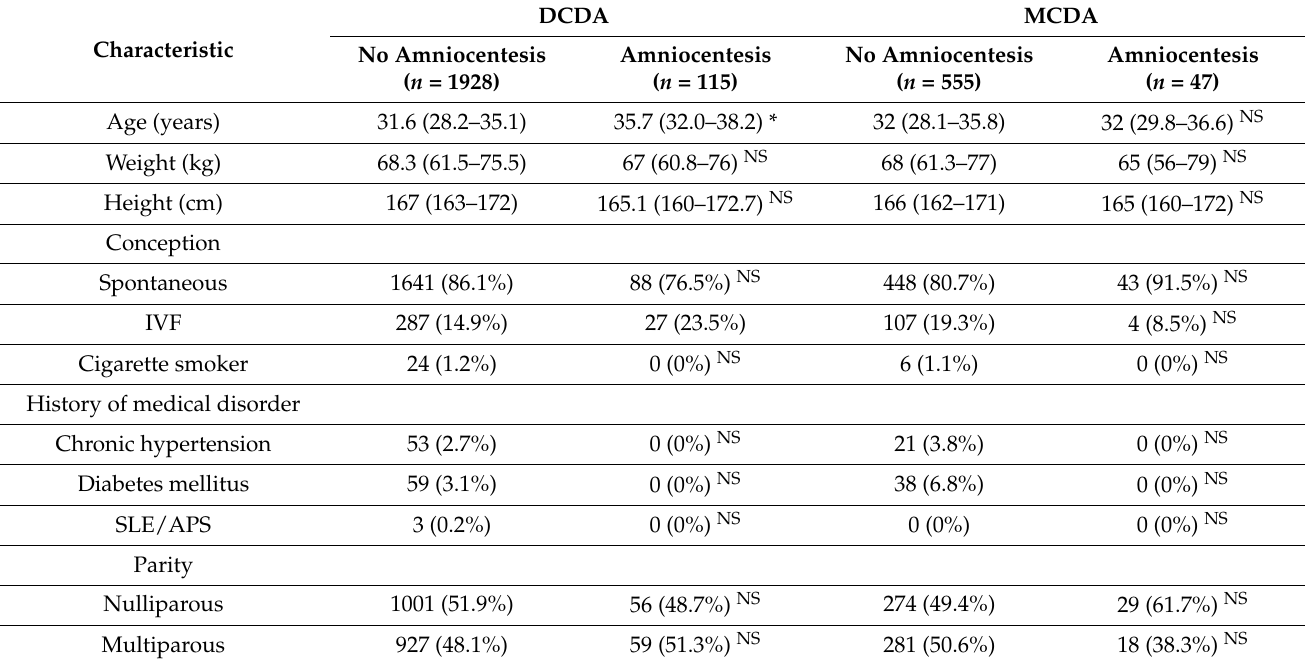
Table 1. Maternal and pregnancy characteristics in the study